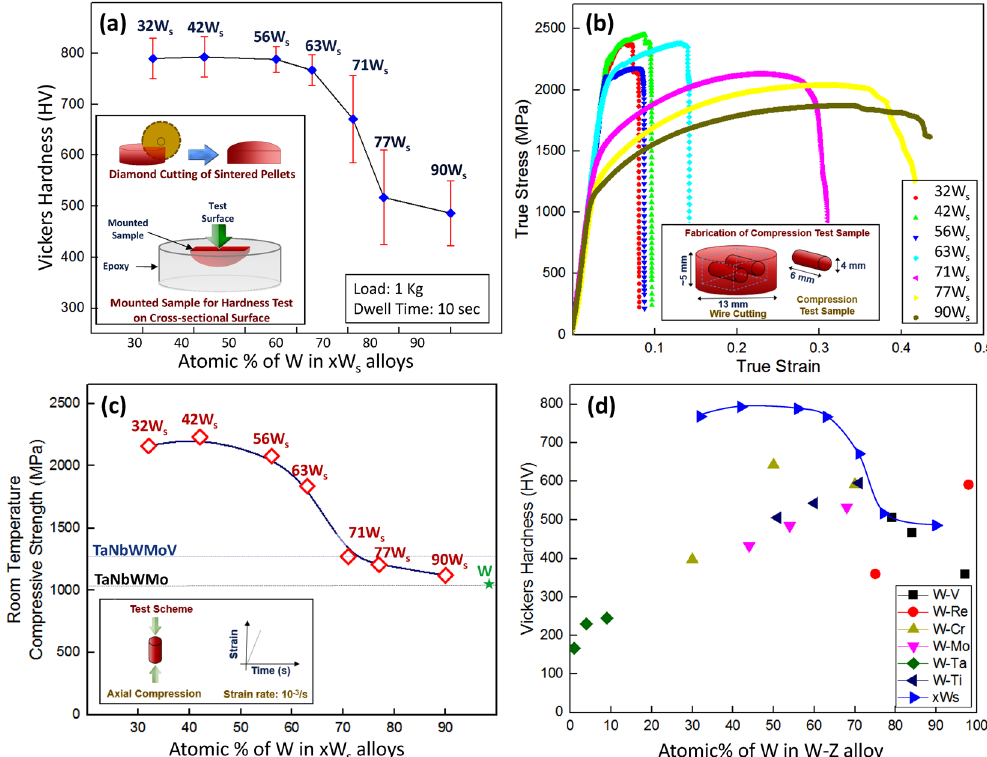
Figure 6. ( a ) Effects of the composition on the hardness of xW s , ( b ) true stress-true strain curves of xW s , ( c ) variation in the compressive yield strength and fracture strain of xW s with varying compositions and a comparison with pure tungsten (this work), TaNbWMoV and TaNbWMo 93 and ( d ) Comparison of the hardness levels of xW s with W-V (W-3.5at.%V, W-16at.%V and W-21.3at.%V) 44 , W-Re (W-2at.%Re 48 and W-24.7at.%Re-SPS at 1500 °C) 47 , W-Cr (W-30at.%Cr, W-50at.%Cr and W-70at.%Cr) 58 , W-Mo (W-32.2at.%Mo, W-45.5at.%Mo and W-56.3at.%Mo) 56 , W-Ta (W-99at.%Ta, W-96at.%Ta and W-90.7at.%Ta) 50 , and W-Ti (W-29at.%Ti, W-40.2at.%Ti and W-48.8at.%Ti) 54 .